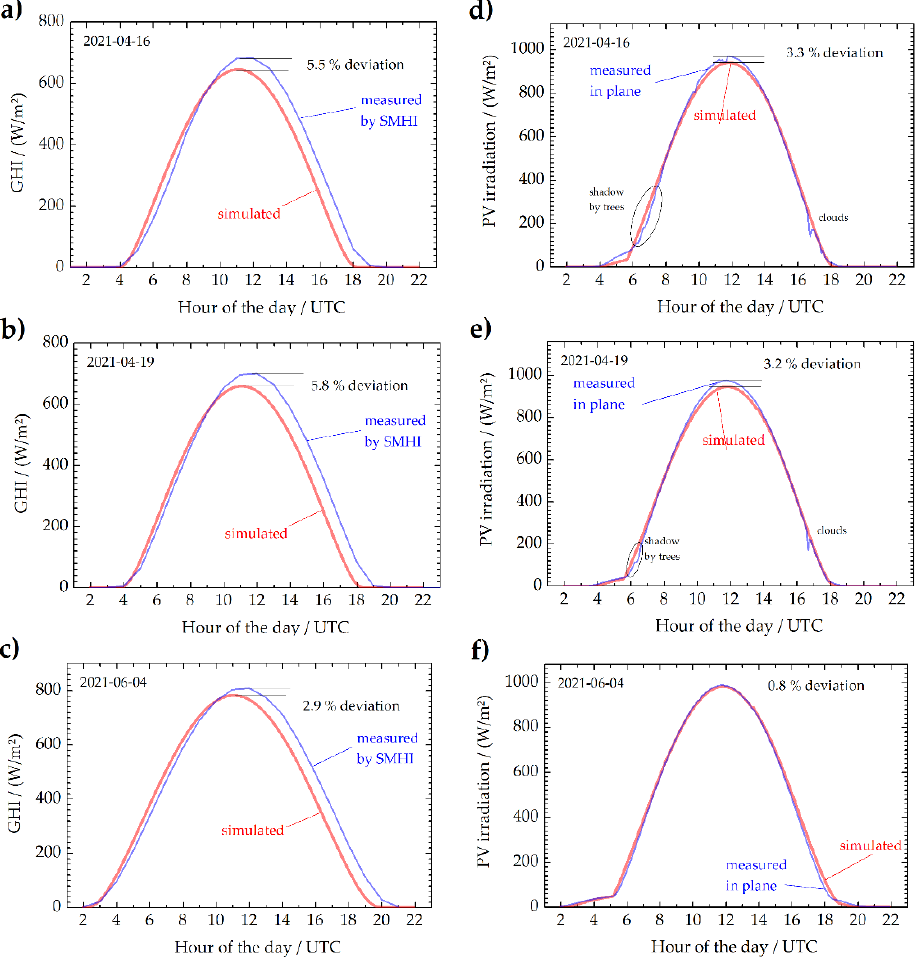
Figure 3. Left column ( a – c ): Simulated and measured global horizontal irradiation (GHI) on three different days (date in the upper left corner). The measurement was done by a local weather station (Sveriges meteorologiska och hydrologiska institut, SMHI). Right column ( d – f ): Simulated and measured irradiation on corresponding days in the plane of the PV modules. The measurement was done using the above-named calibrated detector mounted directly near the PV modules. The simulations were done without shallow angle reflection correction (see Section 3.4).